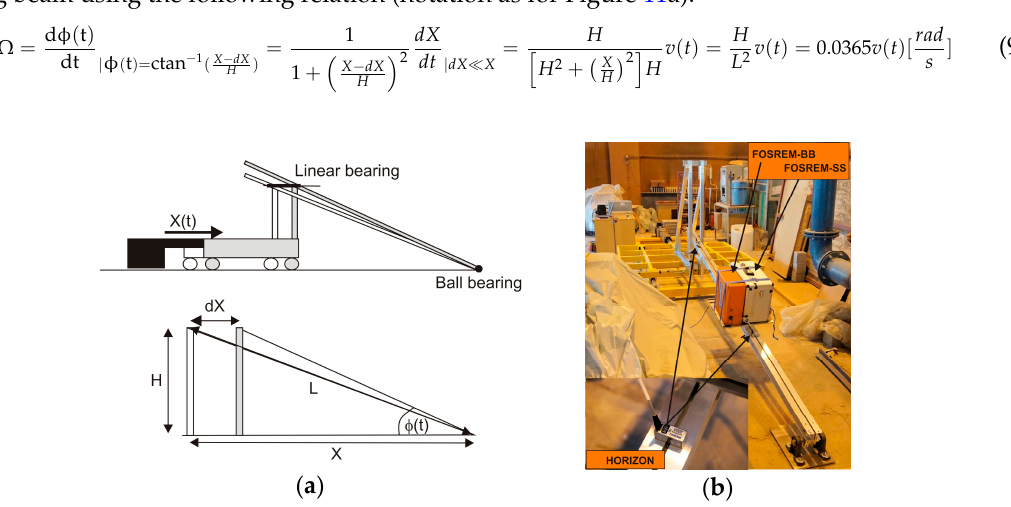
Figure 11. Modified shaking table: ( a ) scheme (top image) and trigonometric dependence for Equation (9) (bottom image: H = 0.5 m, L = 3.7 m); ( b ) general view of shaking table with mounted FOSREMs and HZ1-100-100.